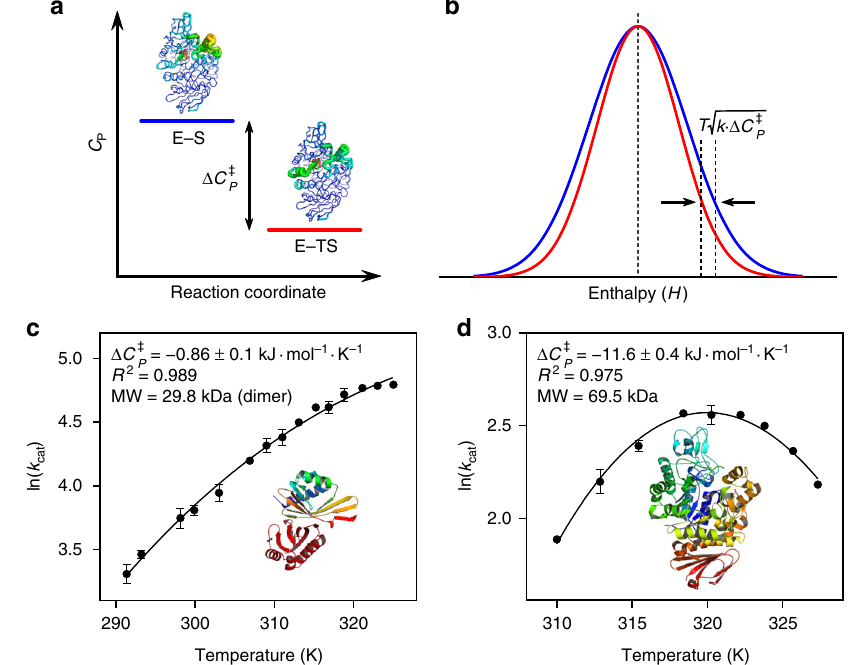
Fig. 1 Basis of a negative Δ C z P and its determination through experiment or simulation. a Conceptual depiction of a difference in C P between the enzyme – substrate (E – S) and enzyme – transition state (E – TS) complexes along a reaction, resulting in a negative Δ C z P . b Conceptual depiction of differences in enthalpy distribution at the E – TS (red) and the E – S states (blue). Arrows indicate the in fl ection points (at μ + σ ), and the difference de fi nes Δ C P between the two states according to the formula given (see Eq. 1). c – d Experimentally determined Δ C z P values (kJ mol − 1 K − 1 ± SE) for the temperature-dependent rates of KSI ( c ) and MalL ( d ). The data are fi t with MMRT (see Methods). Error bars, where visible, represent the standard deviation of three replicates. Structures of KSI and MalL are drawn to